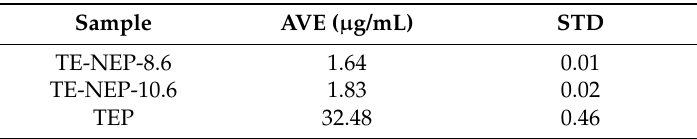
Table 2. Content of curcumin in